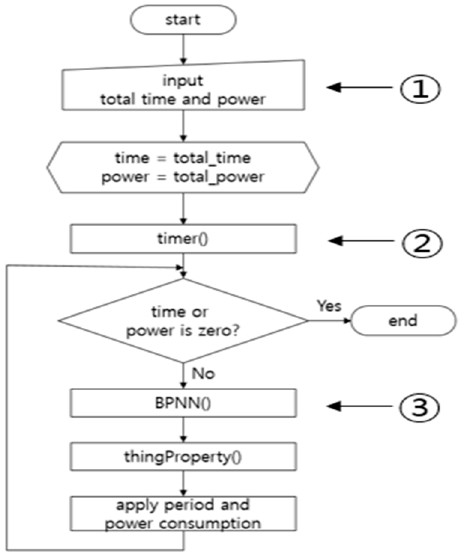
Figure 3. Flow chart of Smart Sensing Period.